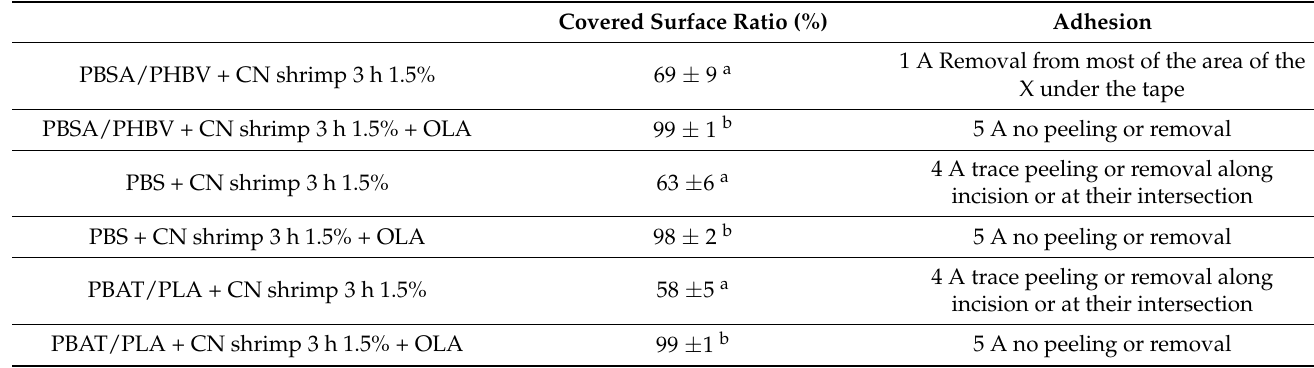
Table 7. Surface analysis of different polyester films coated with chitin from shrimps with and without the addition of OLA. The same letter means that values were not significantly different (confidence level 95%).